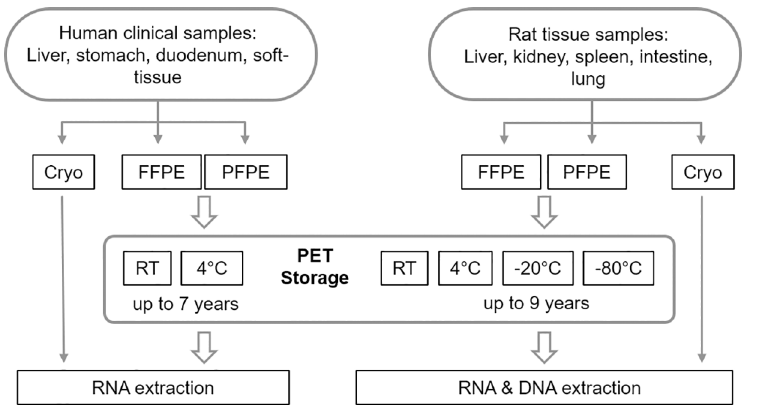
Fig 1. Schematic overview of the study setup. Human clinical or rat tissues were freshly collected, aliquoted and either directly snap-frozen (Cryo), or fixed in 4% neutral buffered formaldehyde (NBF) or in PAXgene Tissue Fix and Stabilizer. Paraffin embedded tissue blocks (PET) were stored under controlled temperatures for up to 7 years in case of human and up to 9 years in case of rat tissues until RNA and DNA extraction.